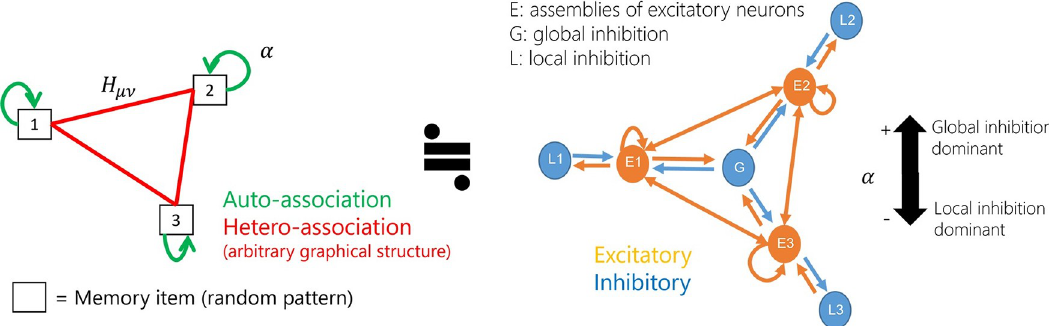
Fig 1. Laplacian associative memory (LAM) model. Left: associative memory network model with auto-association and hetero- association. The parameter α indicates the auto-associative strength. Right: Equivalent biological neural network model which contains local (assembly-specific) and global (non-specific) inhibition. The parameter α indicates the ratio between local and global